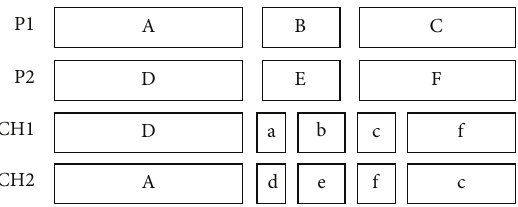
Figure 1: Third crossover